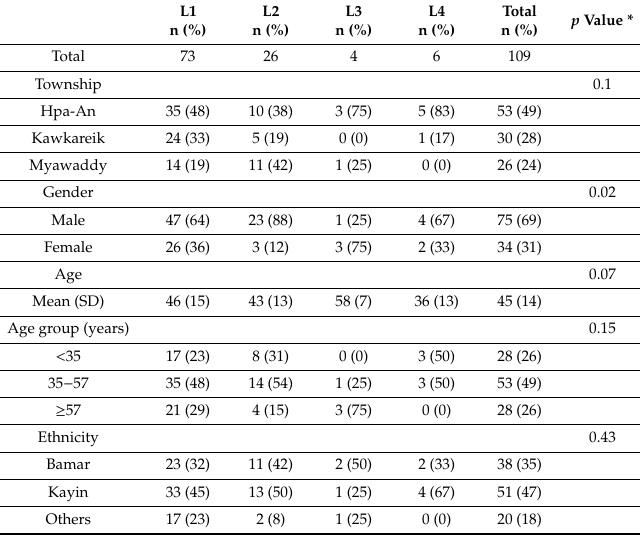
Table 1. The Socio-Demographic Characteristics of tuberculosis (TB) Patients and Major Lineages of Mycobacterium tuberculosis